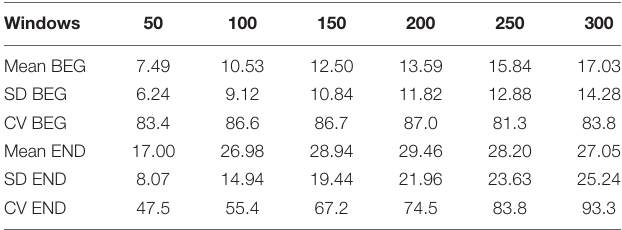
TABLE 1 | The mean, SD, and CV of %RCF > 0.8 for different windows W.